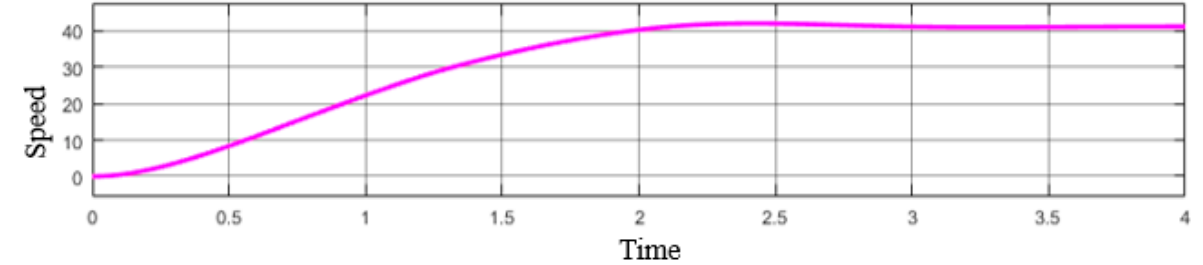
Figure 10. Best simulation result obtained without considering noise in the plant.